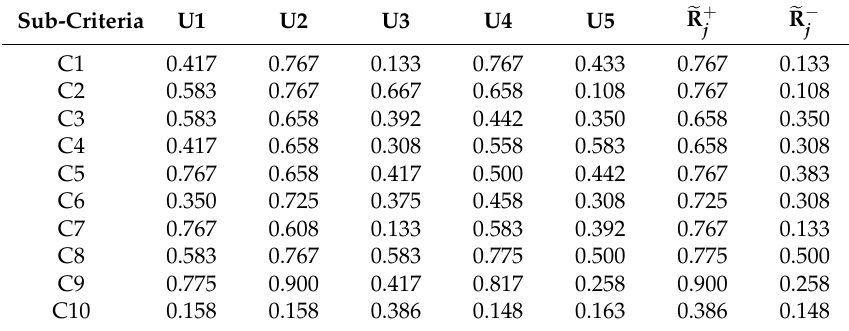
Table 20. The BNP numbers for the standardization evaluation matrix and ideal solutions.